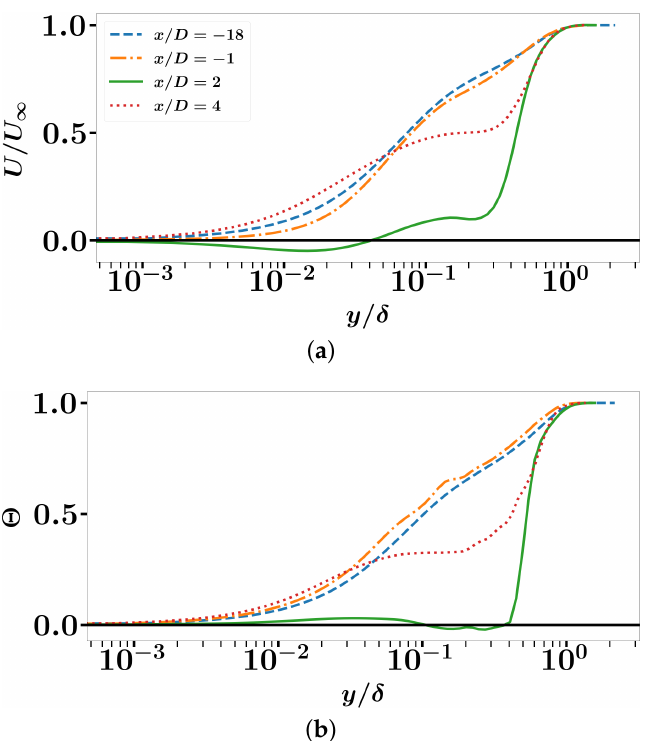
Figure 11. CASE 1: ( a ) mean streamwise velocity in wall units and ( b ) normalized mean